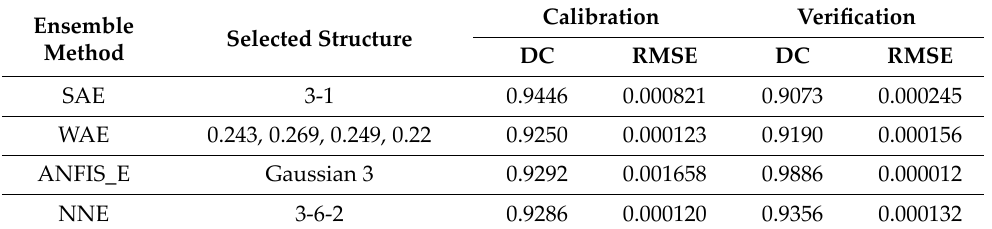
Table 5. The ensemble approach used to model COVID‑19 mortality.